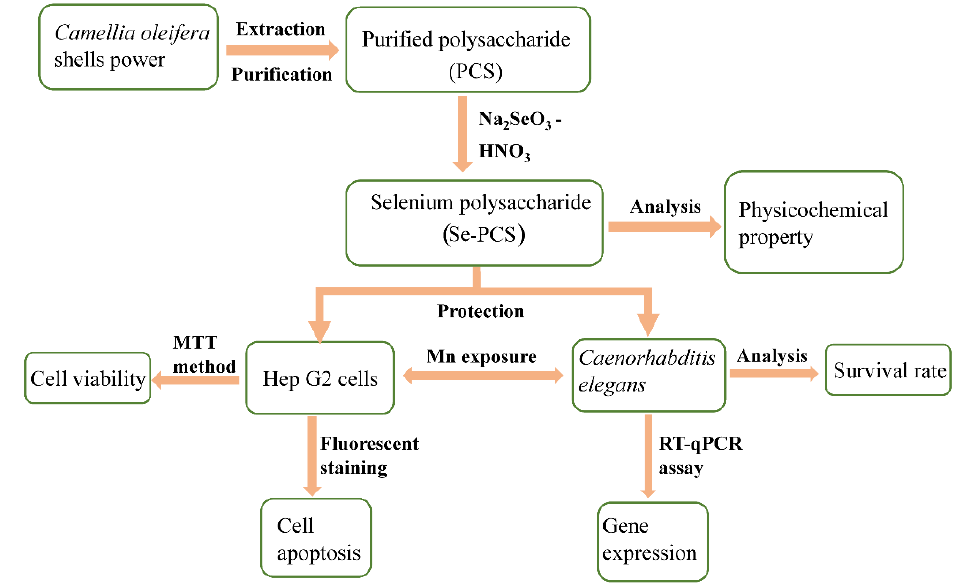
Figure 1. Preparation of Se-PCS and assessment of the protection against Mn toxicity.